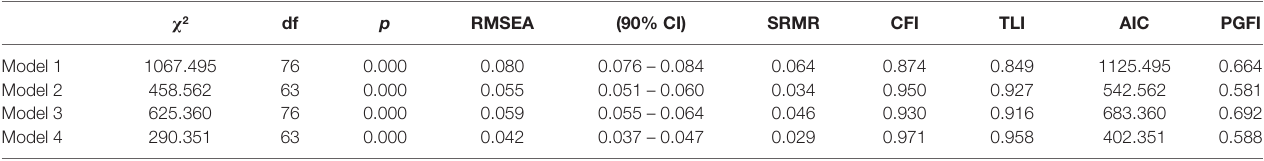
TABLE 3 | Goodness-of-fit indices of different models in the confirmatory factor